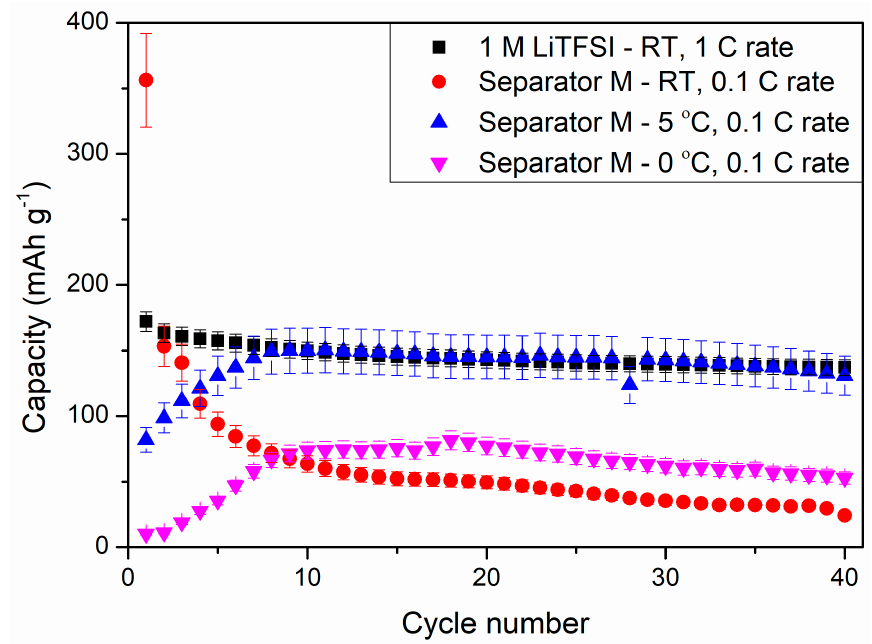
Figure 14. Cyclability tests of PSUR-based UV-cured composite film M applied as a conductive separator and (for comparison) 1 M LiTFSI liquid electrolyte in lithium-ion cells at different temperatures.